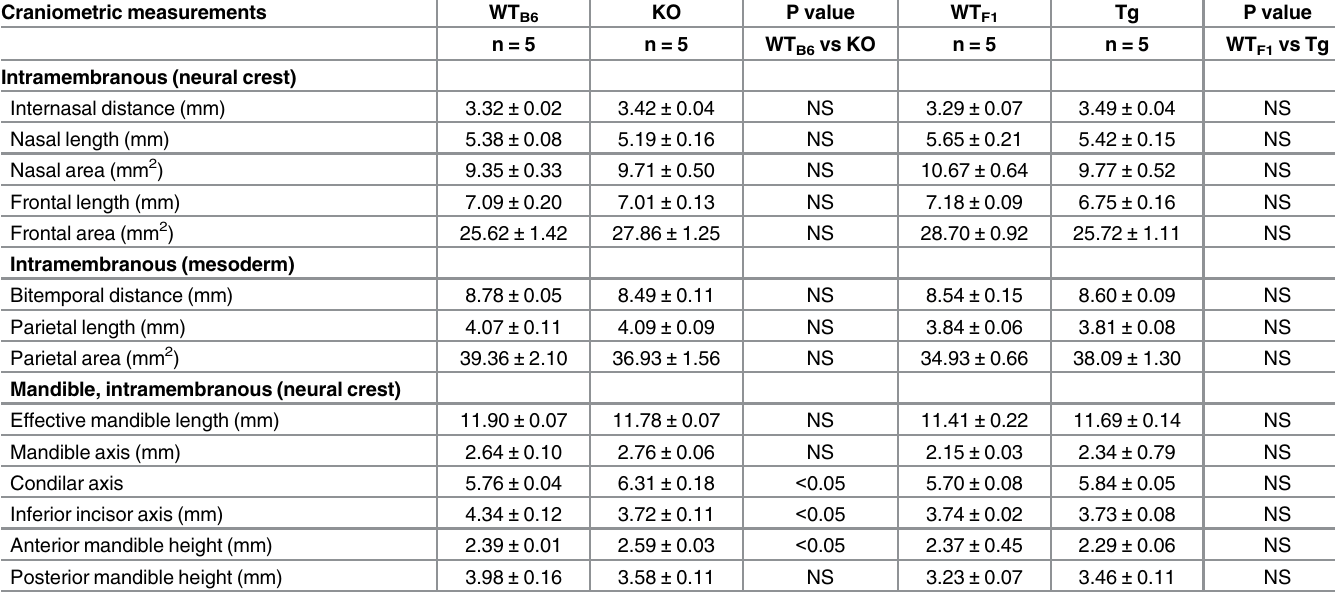
Two-sample t-test was used to compare means between KO and WT B6 , and between Tg and WT F1 . Normality and homogeneity of variance assumptions were not violated in any experimental group (p (cid:3) 0.05). Data represent means ± SEM. Statistical comparisons: p (cid:1)